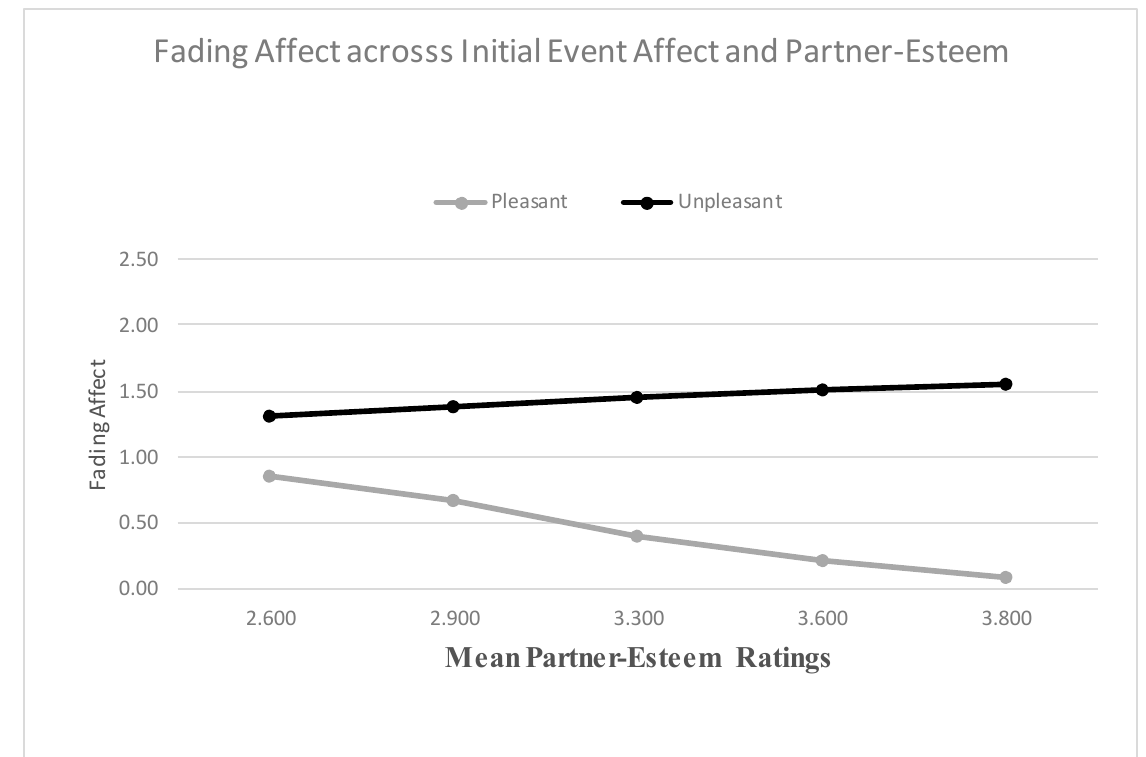
Figure 3. Fading affect for pleasant and unpleasant events across quintile levels (10th through 90th) of self ‐ esteem.